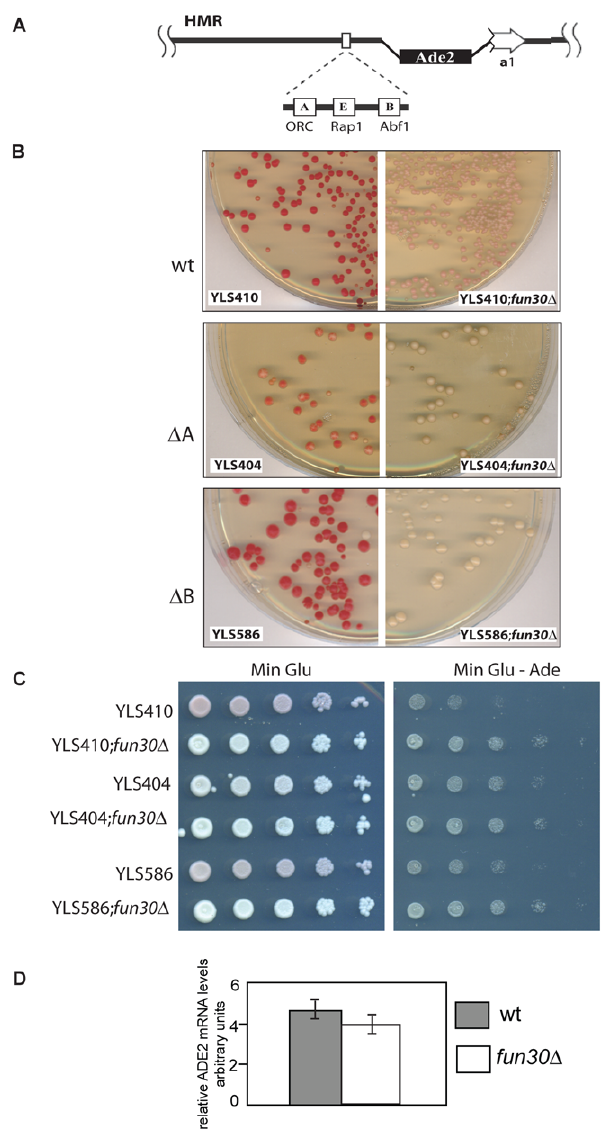
Figure 4. Fun30 is involved in silencing in the HMR locus. A. Diagram of the HMR silencing reporter (adapted from [32]). B. Colonies of the strains YLS410 (wildtype silencer, [32]), YLS404 ( D A silencer, [32]) and YLS586 ( D B silencer, [32]) turn red because of lack of expression of ADE2 . When FUN30 is deleted in these backgrounds, the colonies stay white, indicating derepression of ADE2 . C. The role of Fun30 in repressing the ADE2 reporter embedded in the HMR is tested by monitoring growth in the absence of adenine. The repression of the ADE2 reporter gene in the ‘wt’ strain (YLS410) leads to reduced growth compared to the fun30 D isogenic strain. 10-fold serial dilutions of cells were spotted on agar plates with minimal glucose medium (MinGlu) or minimal glucose medium without adenine (MinGlu-Ade) and incubated for 3 days at 30 u C. D. Fun30 does not regulate ADE2 in its endogeneous locus. The amount of ADE2 mRNA expressed from its endogenous locus in control (JS311, [37]) and its fun30 -deleted sister strain was determined after reverse transcription of the mRNA and quantitative PCR and normalized to ACT1 expression. Shown is the average of two experiments with standard deviation. not regulate ADE2 when it is at its endogenous locus (Figure 4D), showing that its silencing function is linked to the repressed state of the HMR locus.